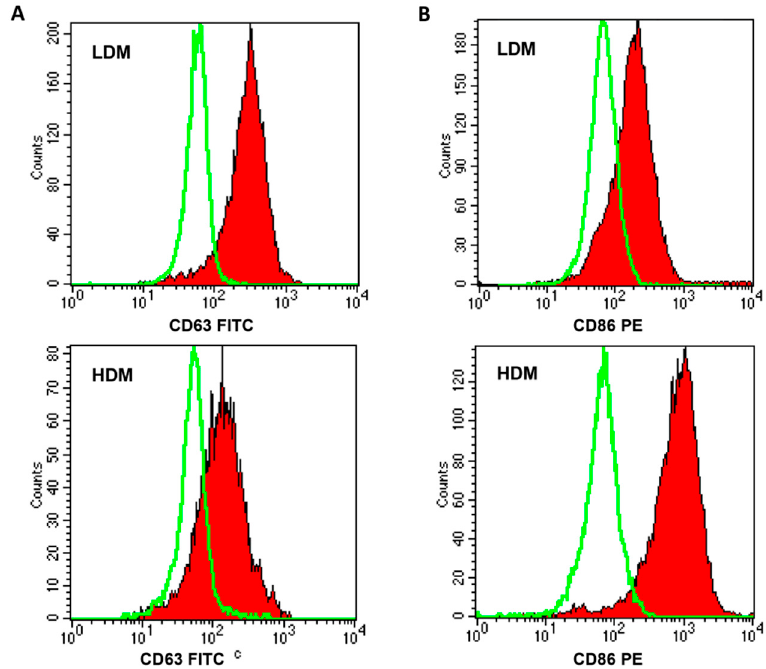
Figure 4. FACS analysis of CD63 and CD86 expression on LDMs and HDMs. Freshly purified lung macrophages from the two subpopulations were suspended in PBS at a concentration of 5 × 10 6 /mL. Fifty microliters of cell suspension were incubated (4 °C, 20 min) with saturating amounts of FITC-conjugated anti-CD63 (Panel ( A ), closed histogram) or PE-conjugated anti-CD86 (Panel ( B ), closed histogram) Abs. Background fluorescence (Panels ( A ) and ( B ), open histogram) was assessed using isotypic control Abs. Quenching of macrophage autofluorescence and flow cytometry analysis were performed as described in Materials and Methods. The figure shows the results of one representative experiment of the six performed.